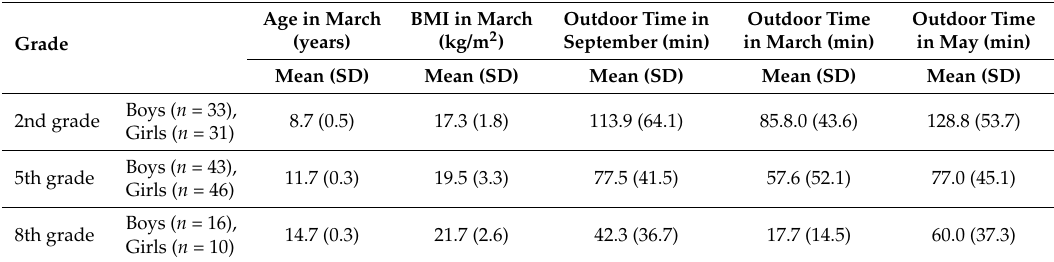
Table 1. Mean and standard deviation (SD) of participant’s age and BMI in March, and outdoor time in different grades and seasons.